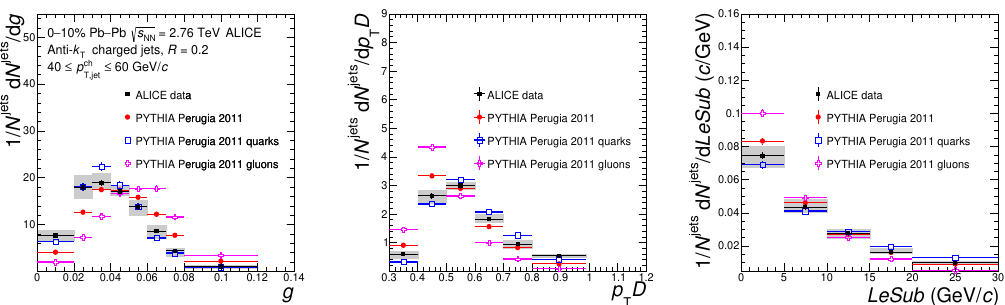
p s NN = 2 : 76 TeV for